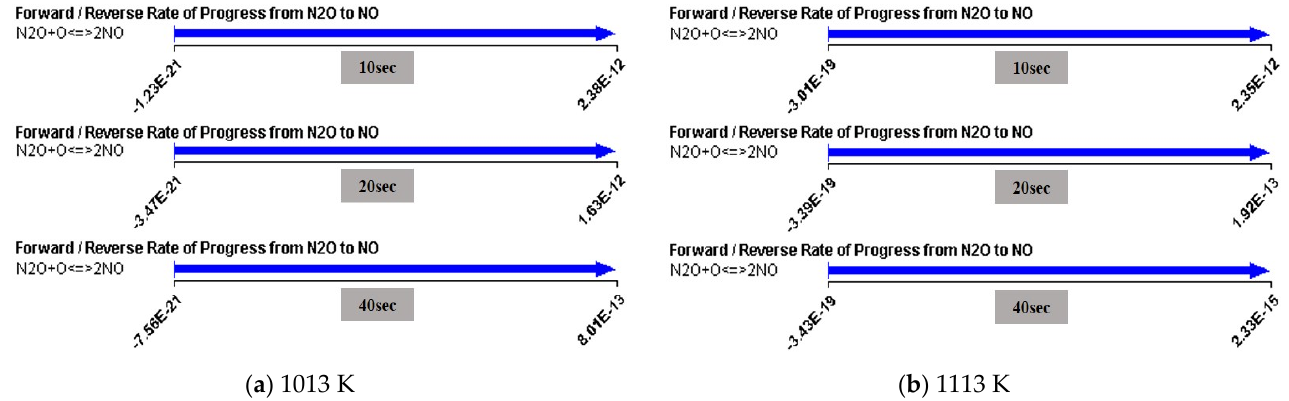
Figure 9. Rate of progress from N 2 O to N 2 (M/cm 3 s) at 1013 and 1113 K.